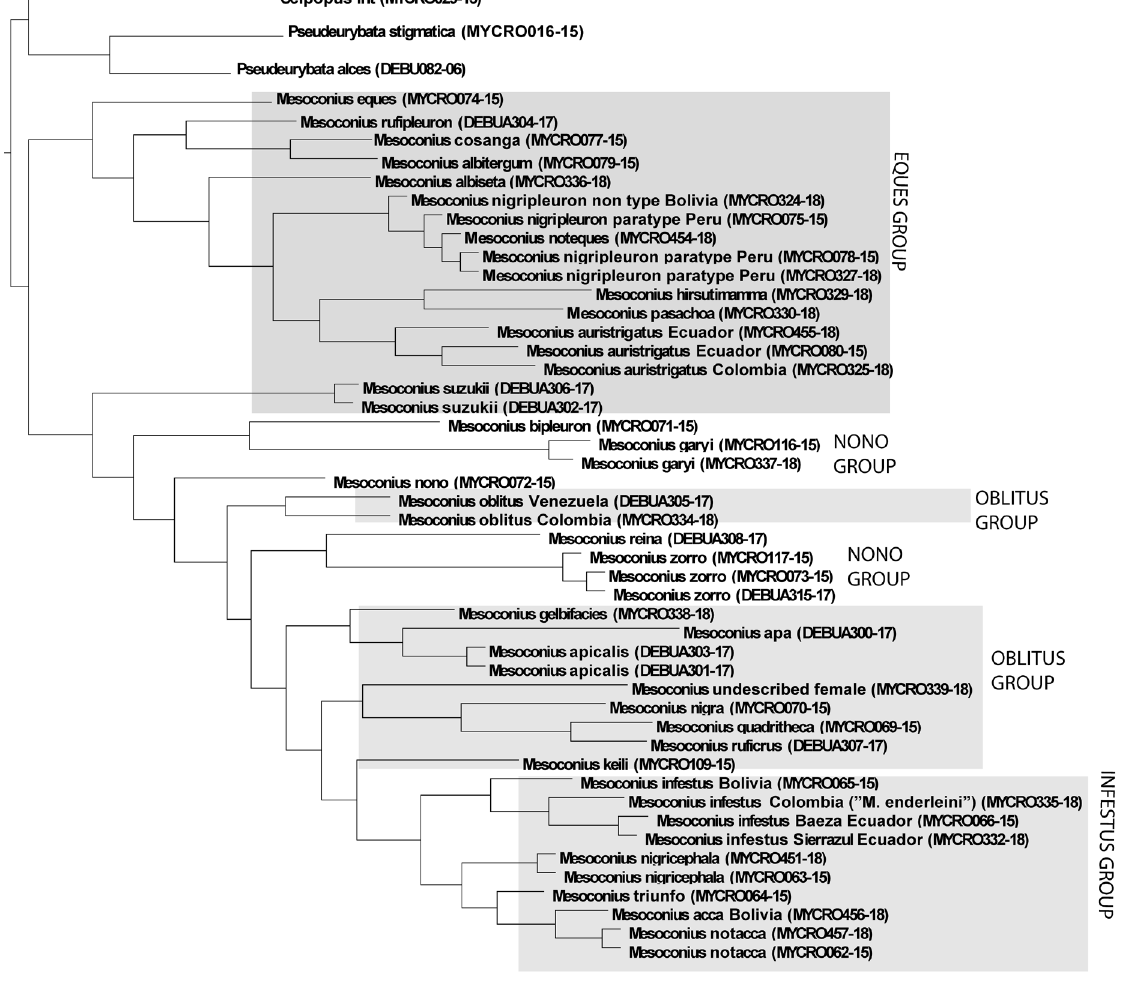
Fig. 50. Maximum likelihood tree from CO1 barcodes. Sequences were aligned using BOLD (amino acid based HMM) and then manually corrected. Maximum likelihood analysis was performed in RAxML (ver. 8.2) using GTR-G with 100